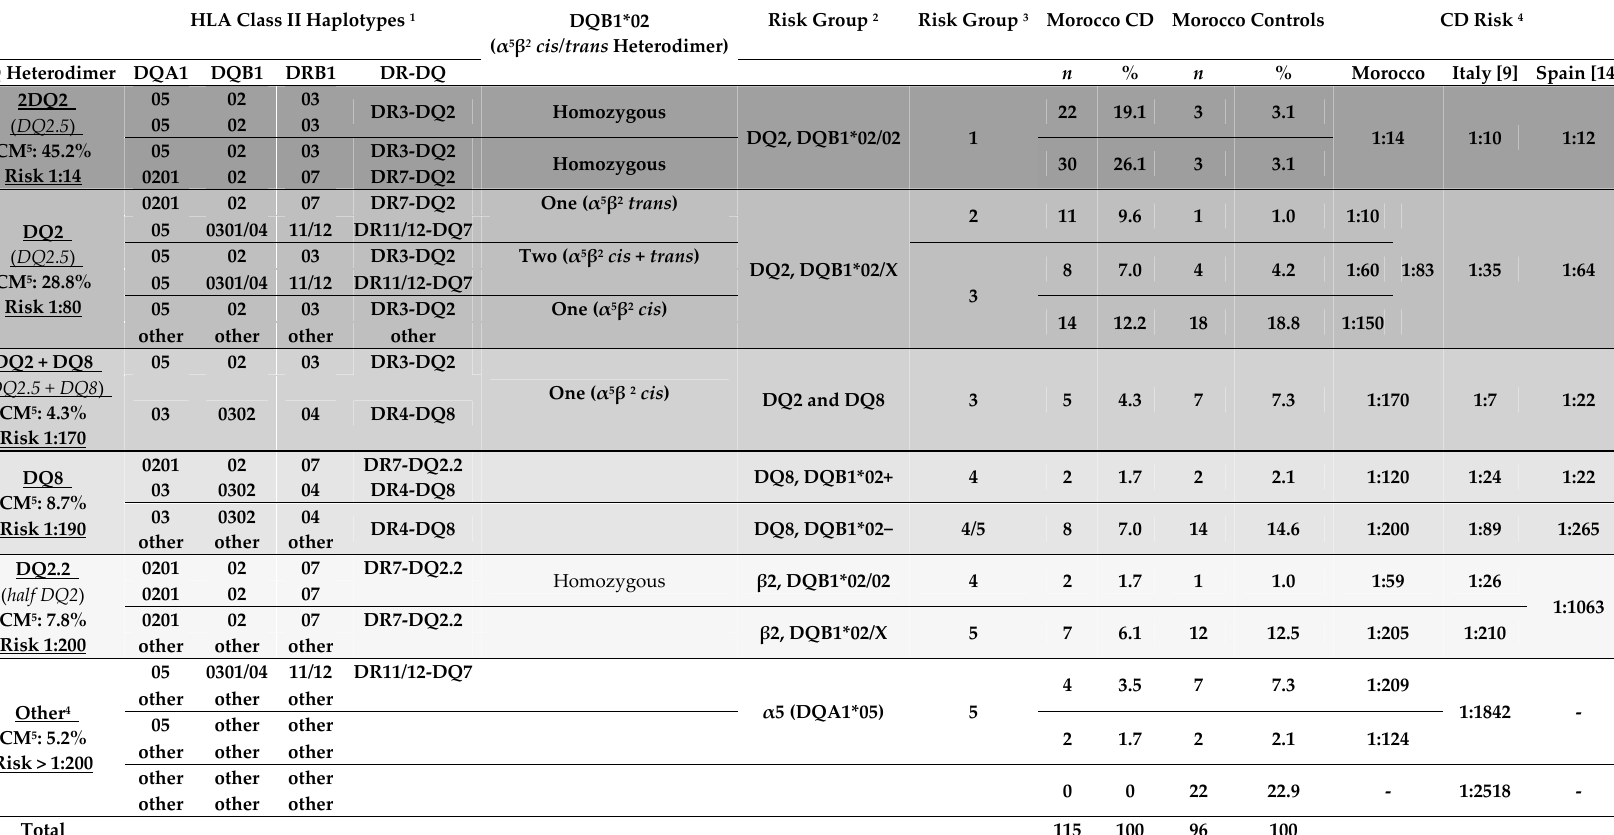
Table 1. Celiac disease (CD)-associated human leukocyte antigen (HLA) class II genotypes, haplotypes, and corresponding disease risk according to Margaritte-Jeannin [8] and Megiorni [9] classification, in Moroccans and comparison with Italian [9] and Spanish [14] genetic risk for CD. The gray background shows the risk gradient associated with genotypes/haplotypes: dark gray = higher risk; light gray = lower risk; white = low or no